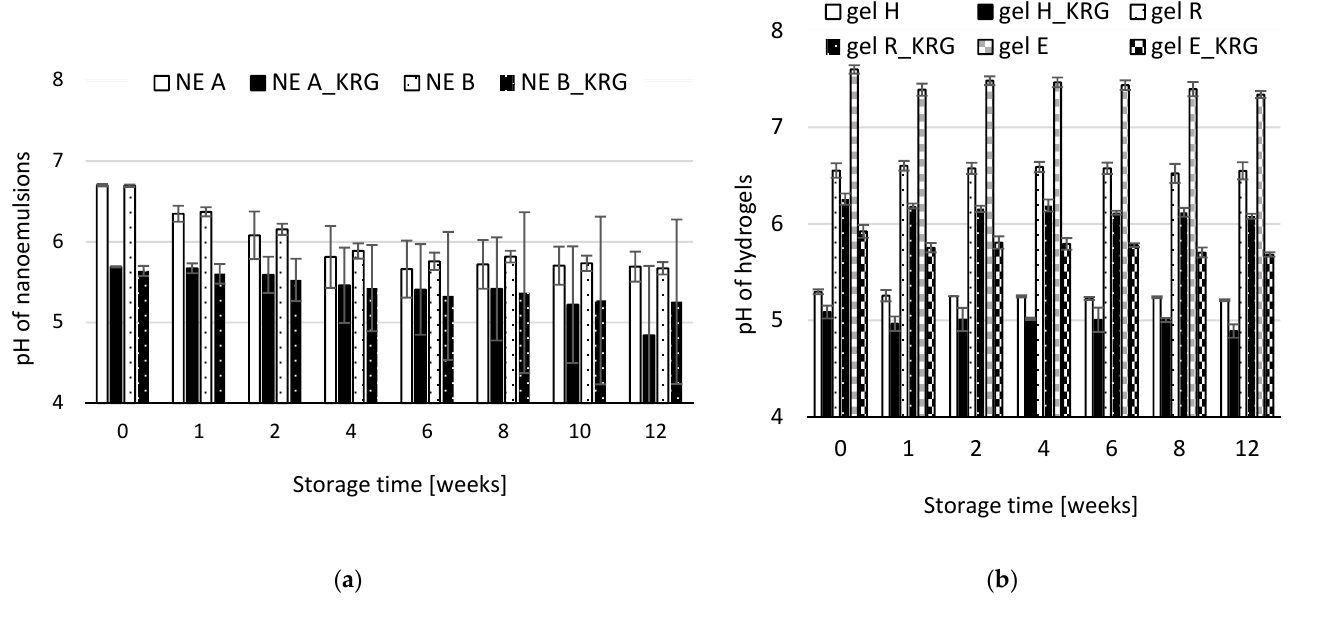
Figure 5. pH value of (a) oil-in-water NEs and (b) hydrogels with and without KRG extract. ( a ) white bars: NE A, black bars: NE A_KRG, white dotted bars: NE B, black dotted bars: NE B_KRG. ( b ) white bars: gel H, black bars: gel H_KRG, white dotted bars: gel R, black dotted bars: gel R_KRG, grey checkered bars: gel E, black checkered bars: gel E_KRG. Values are means ± SD of n = 3 experiments.